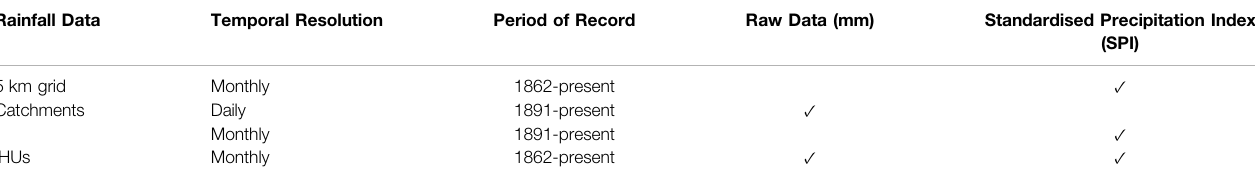
TABLE 1 | Summary of rainfall data available in the UK Water Resources